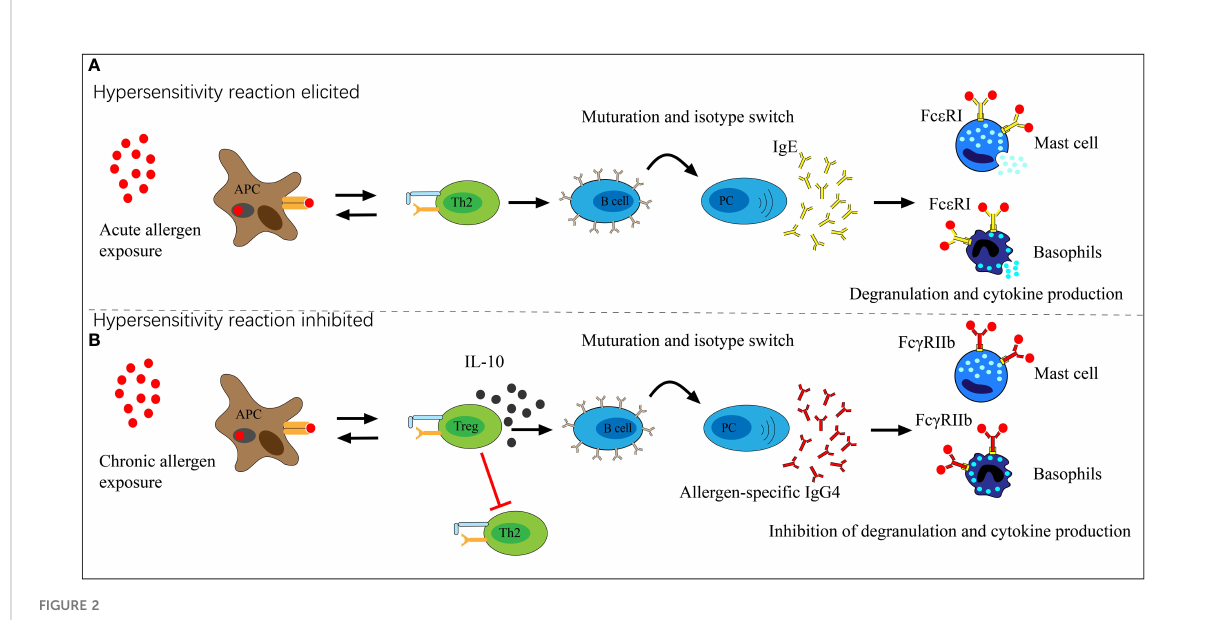
FIGURE 2 The role of allergen-speci fi c IgG4 in allergen exposure. (A) Acute allergen exposure may lead to IgE-mediated histamine-induced hypersensitivity reactions by high-af fi nity receptor Fc ϵ RI. (B) Chronic allergen exposure may induce IgG4 formation and allergen binding by IgG4, thereby binds to the inhibitory receptor Fc g RIIb which prevents hypersensitivity reactions and induces allergen